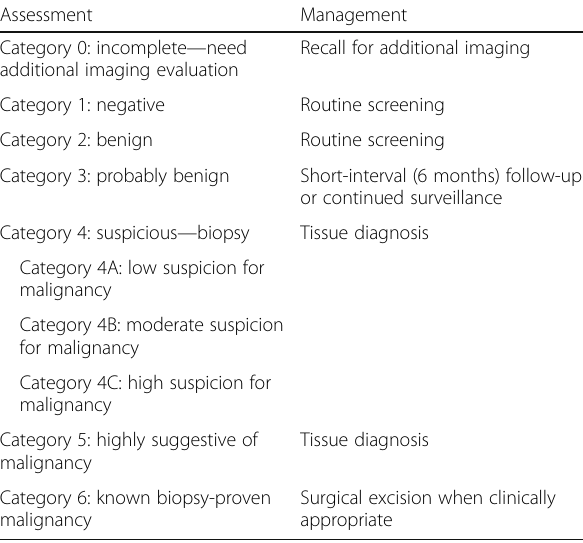
Table 1 BI-RADS US assessment